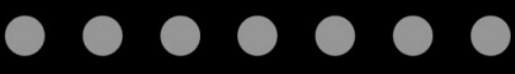
Figure 7. Retro-reflective targets used in the study.